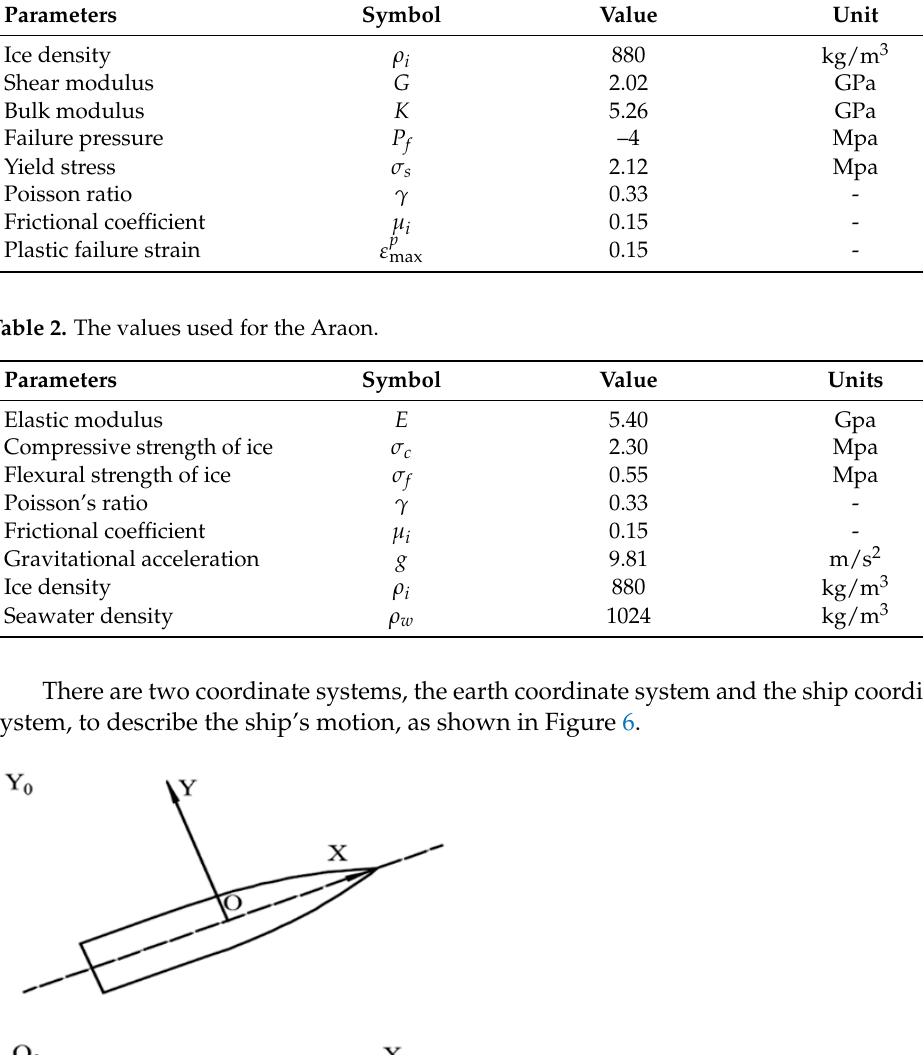
Figure 6. Schematic diagram of the coordinate system. Table 1. Parameters of sea ice materials in the numerical model.